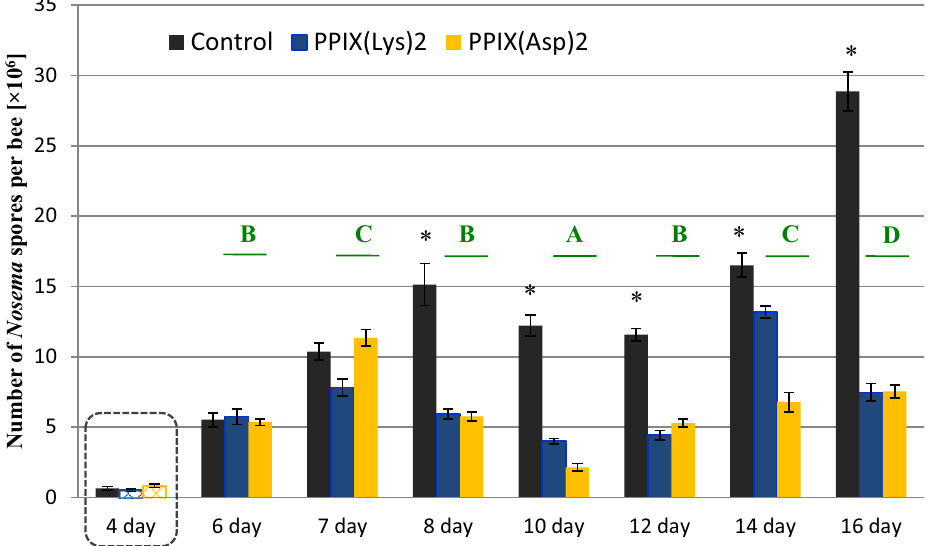
Figure 2. Effect of amide derivatives of protoporphyrin IX on the number of Nosema ceranae spores in infected Apis mellifera . Statistically significant differences between the infected control group and porphyrin-treated groups on a particular day are indicated with asterisks; block letters (A,B,C,D,E) indicate statistically significant differences between the days in the porphyrin groups. The dashed line indicates groups of infected bees prior to porphyrin administration. The error bars represent standard errors of